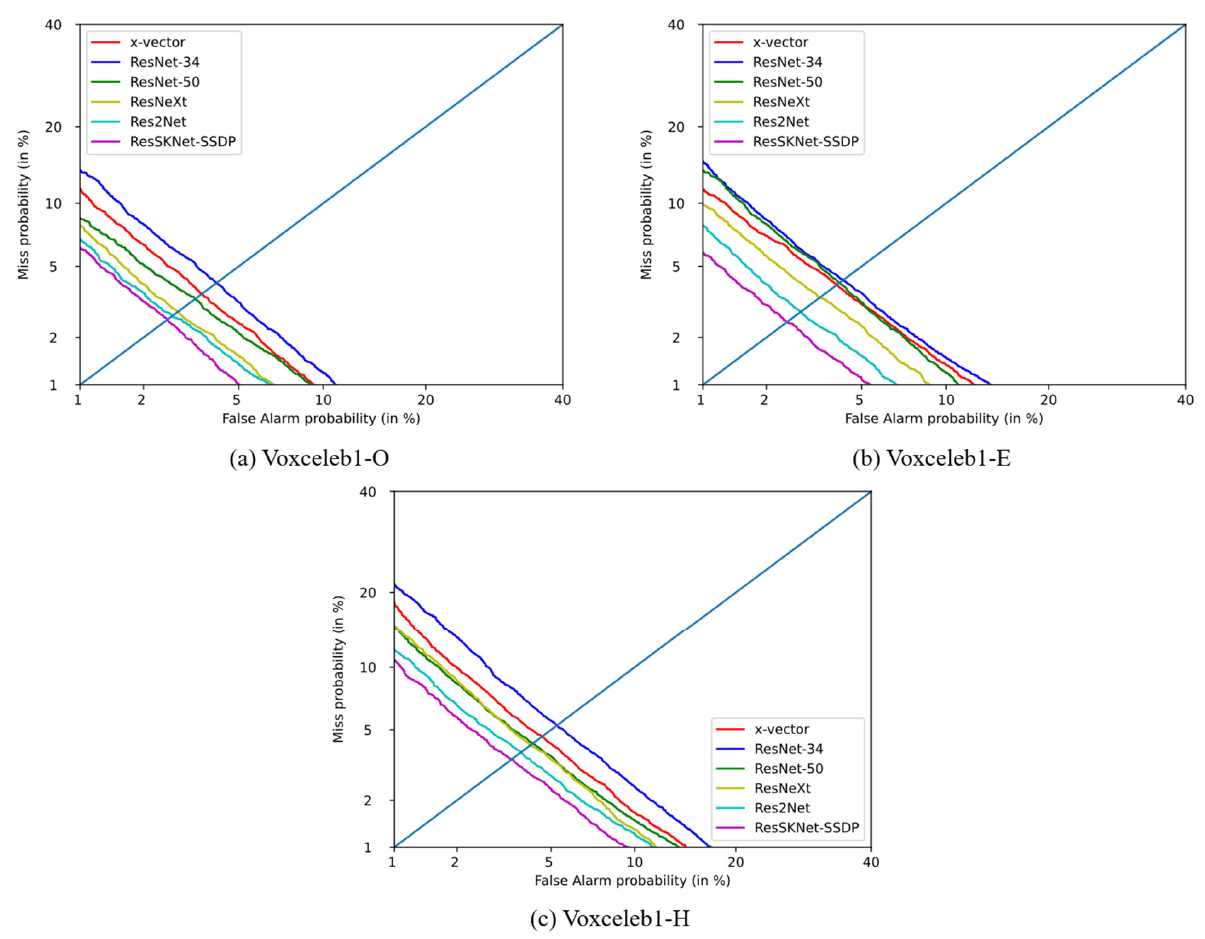
Figure 5. DET curve of different systems on Voxceleb1 test set.